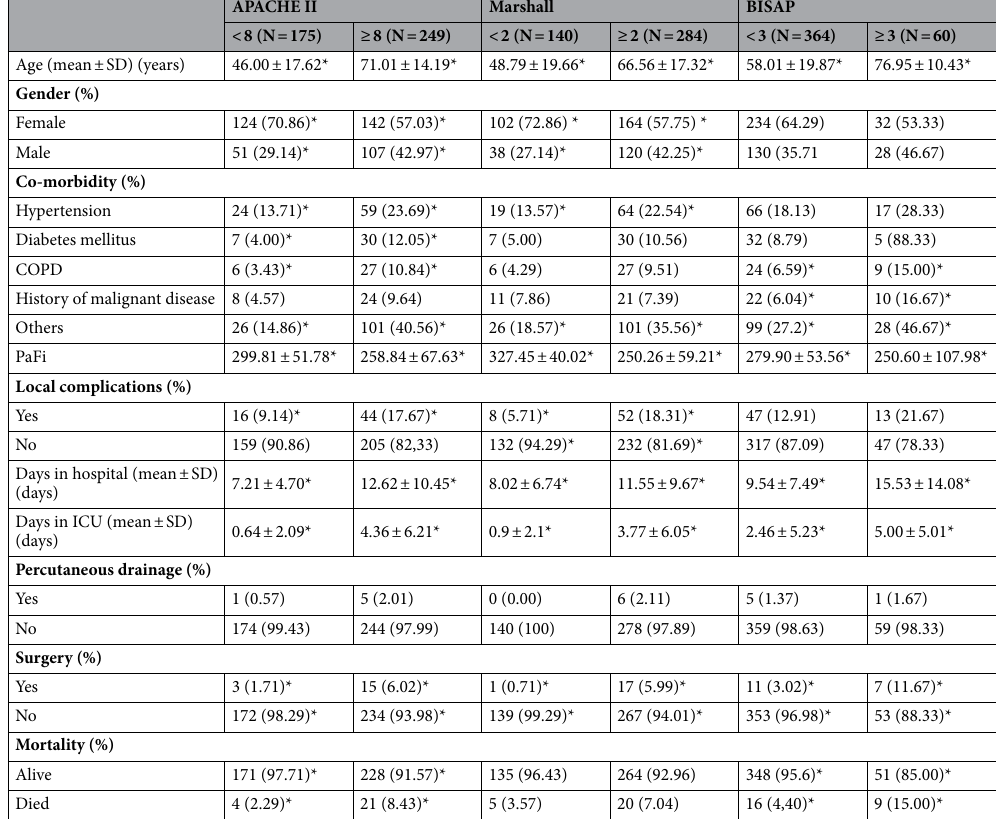
Table 3. Characteristics according to severity scores. *p-values < 0.05 were statistically